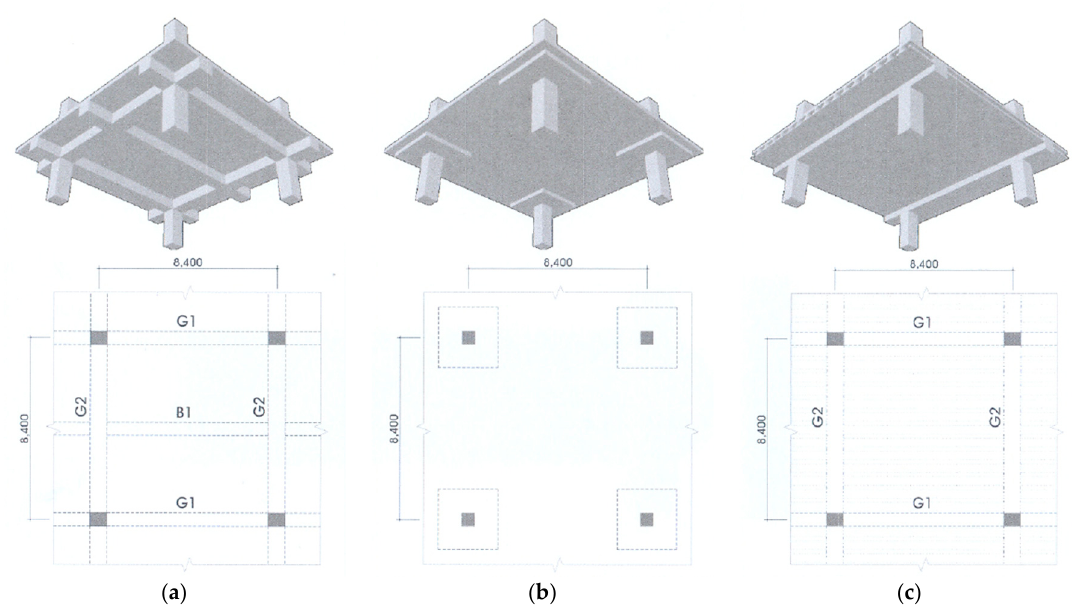
Figure 1. Schematic of the slab systems in a building : ( a ) Ordinary reinforced concrete slab system, ( b ) Flat plate slab system, ( c ) Voided slab system